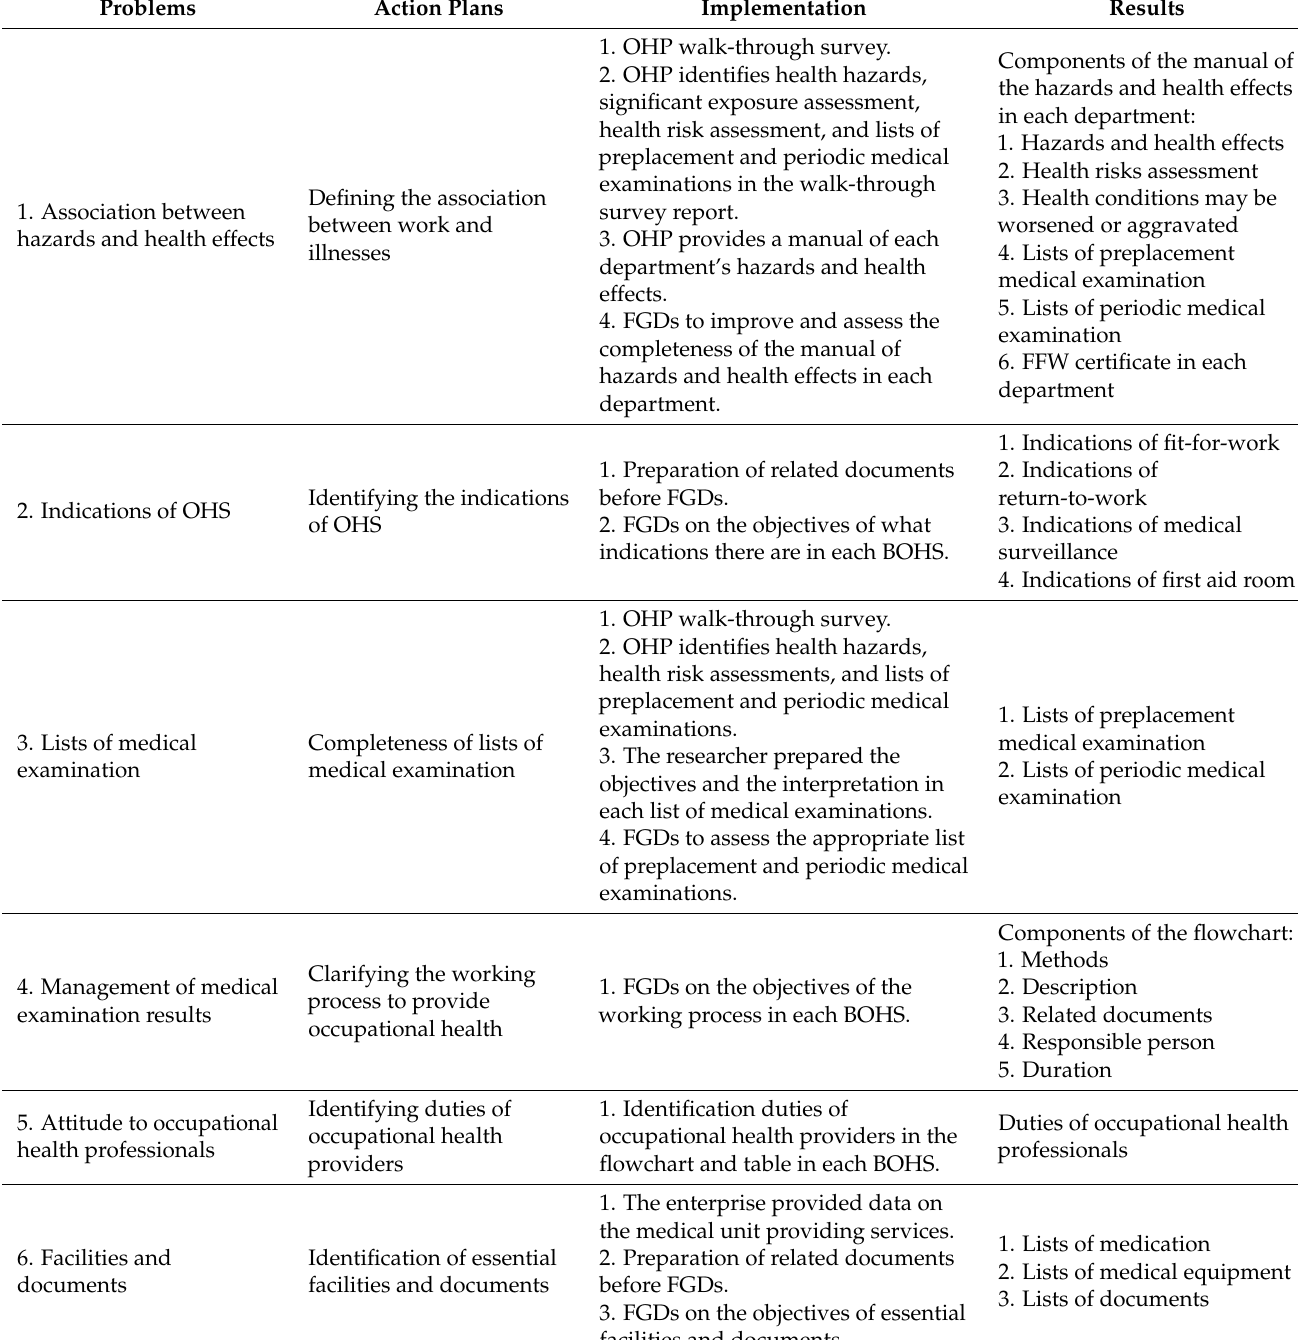
Table 9. Problems, action plans, implementation, and results of loop